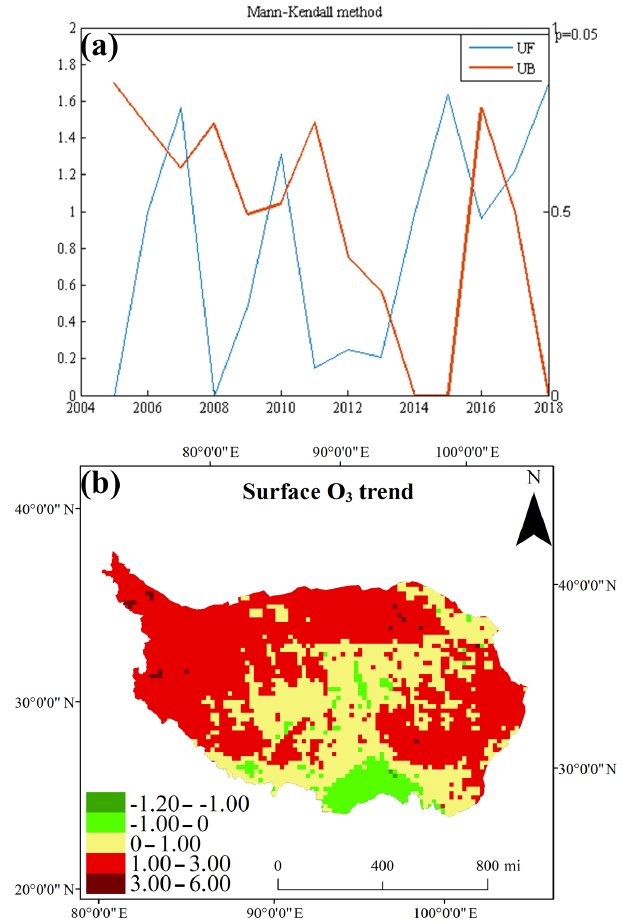
Figure 8. The trend analysis of predicted 8h O 3 concentration. Pan- els (a) and (b) represent the result of Mann–Kendall method and discrepancy of estimated O 3 level during 2005–2018 across the Ti- betan